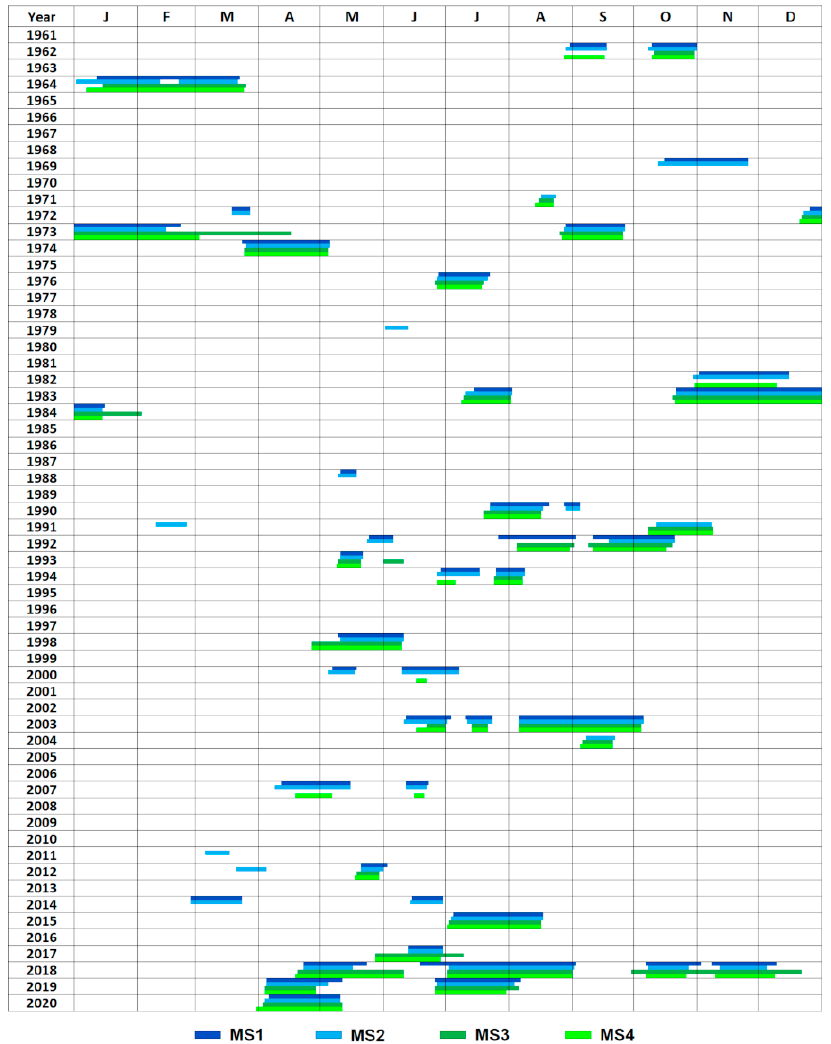
Figure 5. Delimitation of 10th-percentile soil drought episodes for the Czech Republic, according to four SoilClim model setups (MS1–MS4) in the 1961–2020 period.